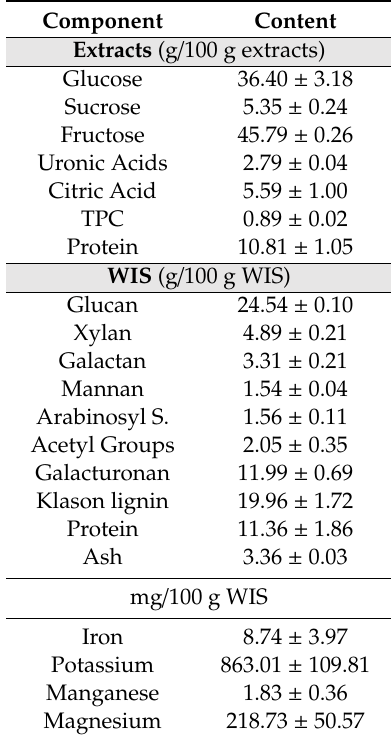
Table 1. Chemical composition of the aqueous extracts and the water-insoluble solids (WISs) on a dry